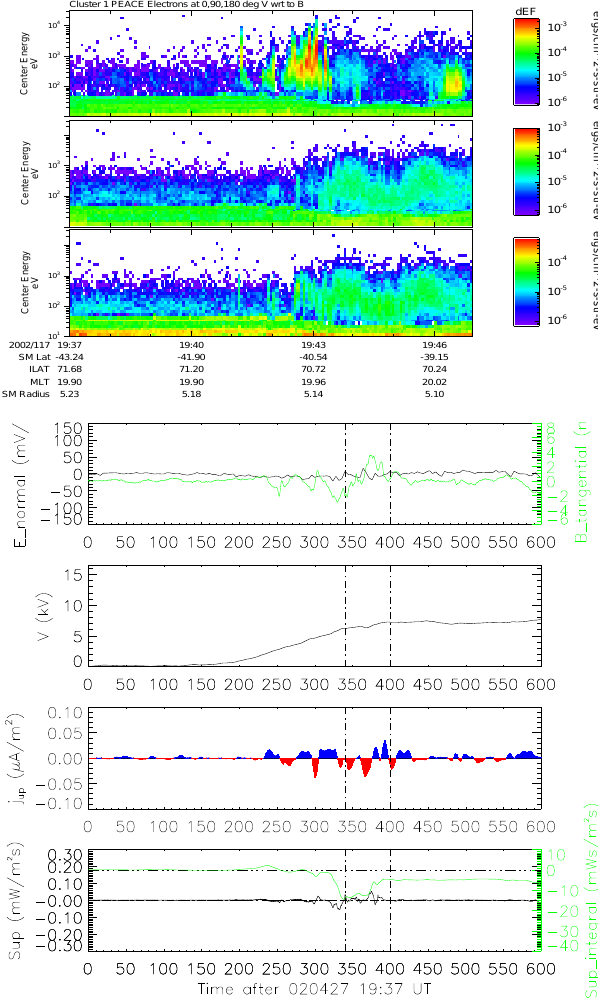
Fig. 7. 27 April 2002, s/c 1. The same panels as in Fig. 2. The verti- cal dash-dot lines delimit the region of dominating spatial variations (see the